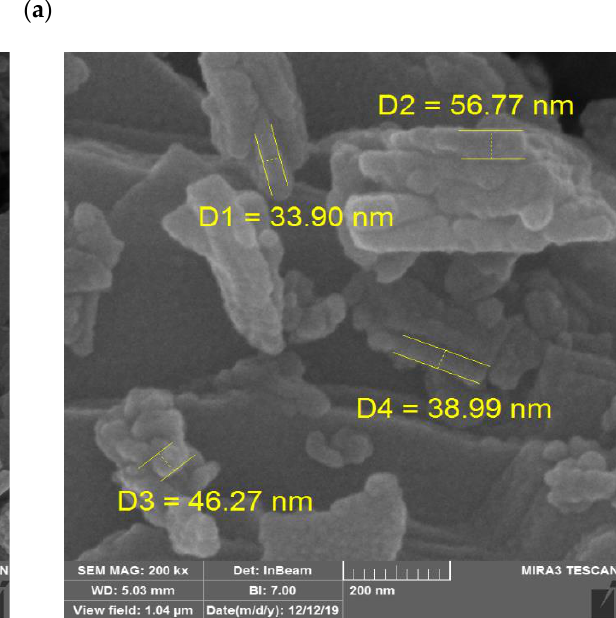
Figure 1. XRD analysis of natural zeolite (a), activated carbon (b), and activated alumina (c). Q: quartz; M: mordenite; C: clinoptilolite; F: feldspar.